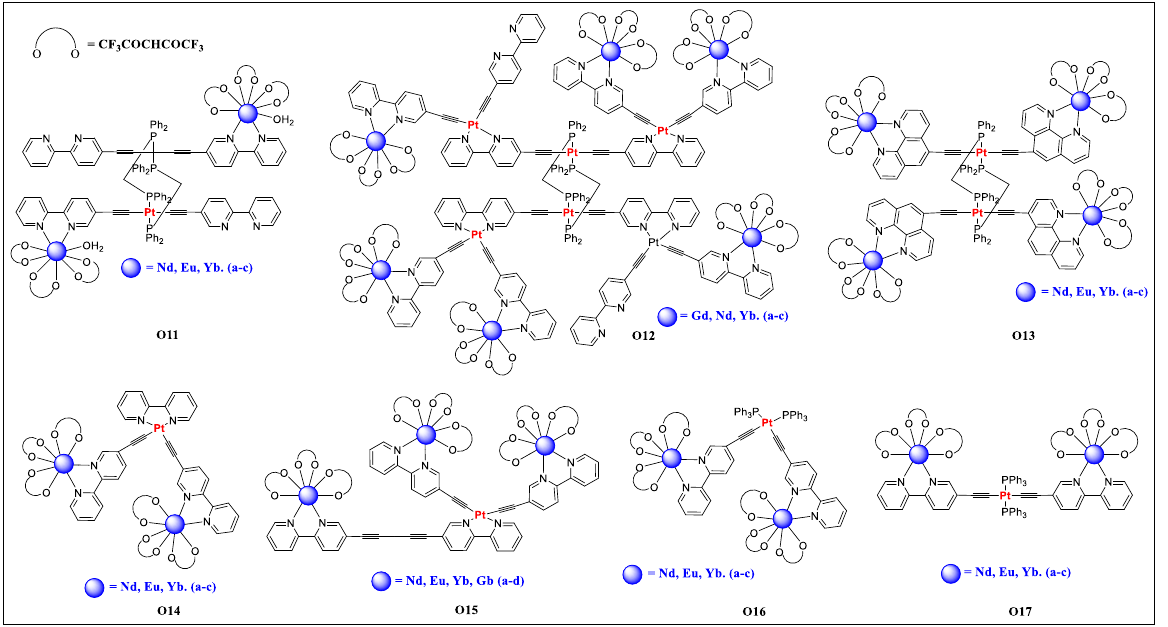
Figure 11. Acetylide-functionalized diimine-based hetero-multimetallic complexes with different lanthanides metal ions ( O11 – O17 ).